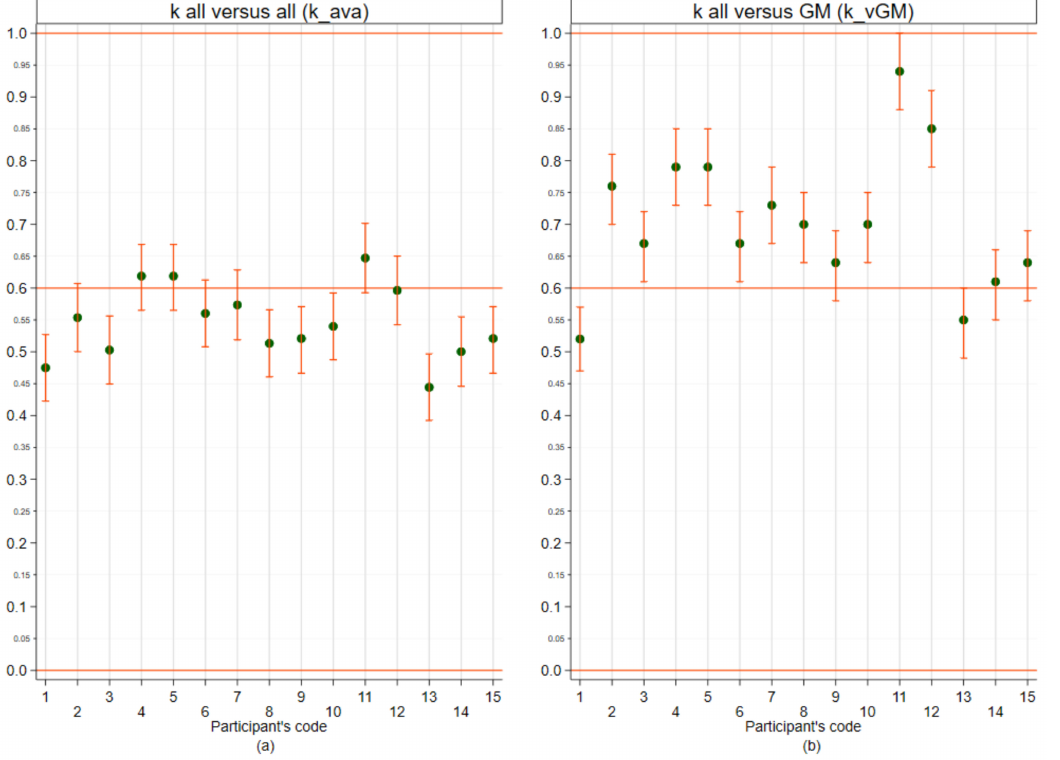
Figure 3. Performances of the panellists for outcomes expressed in terms of ICD-O morphological code/diagnosis. ( a ) mean k of each panellist versus all (k_ava); ( b ) mean k of each panellist versus GM (k_vGM). The points (green) represent the mean of Cohen’s k for each panellist; the vertical bars (orange) represent the 95% confidence interval. The horizontal line (red) represents the value above which the agreement is considered